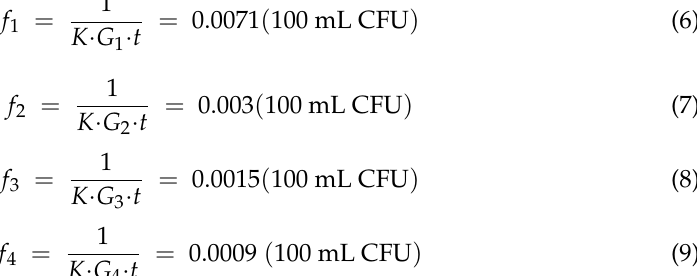
Table 4. Microbiological indicators of reservoir water content (Gozone = const).